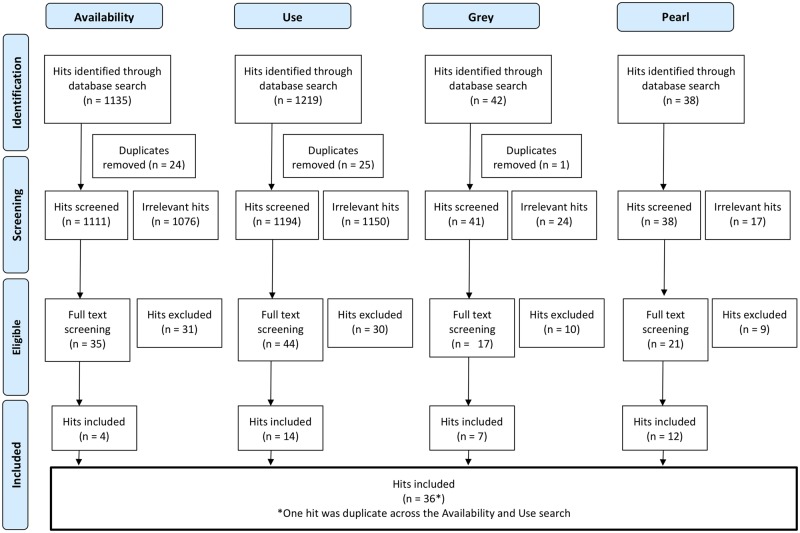
PRISMA flow chart.